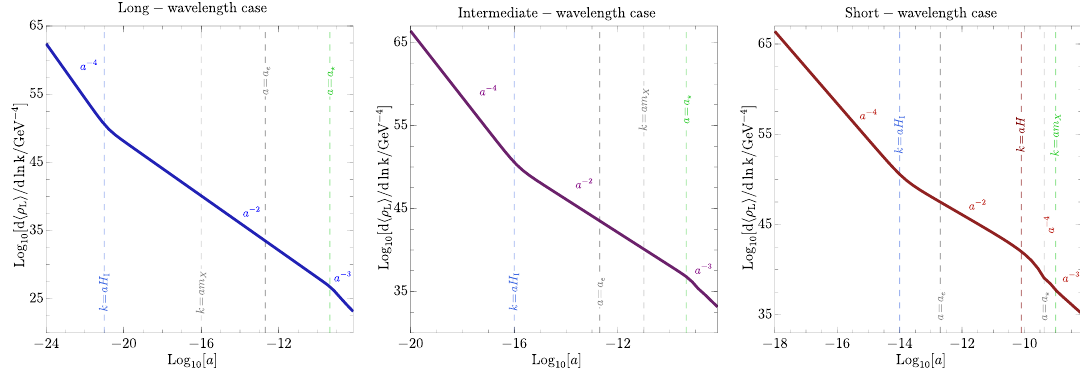
Figure 6 . Evolution of the energy density per log momentum d h (cid:26) L i = ( d ln k ) with the scale factor a for di(cid:11)erent choice of wavevector k : long-wavelength k<k m (left-panel), intermediate-wavelength k m <k<k ? (middle-panel), and short-wavelength k ? <k<k e (right-panel). The numerical analysis presented here agrees with the analytical predictions. Here we choose the parameter m X = 10 8 GeV, H I = 10 13 GeV, w = 0 and k = 10 (cid:0) 8 GeV ; 10 (cid:0) 3 GeV, and 4 GeV for left, middle, and right plots,